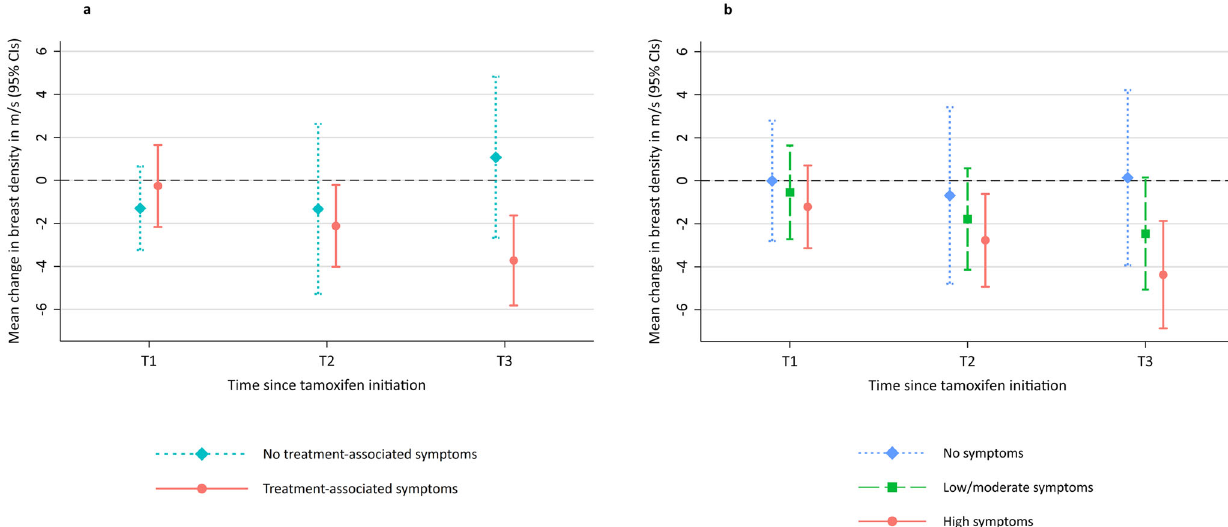
Fig. 2 Multivariable-adjusted mean change in breast sound speed (m/s) by treatment-associated endocrine symptoms and endocrine symptom frequency. a By treatment-associated endocrine symptoms. Treatment-associated endocrine symptoms were de fi ned as either emergent or worsening vasomotor symptoms and/or joint pain after tamoxifen initiation. P-trend for those with symptoms = 0.004, P-trend for those without symptoms = 0.18; P-interaction between endocrine symptom group and time = 0.02. b By endocrine symptom frequency. Endocrine symptom frequency was assessed with a Likert scale for symptom frequency per week (vasomotor and joint pain) and per day (vasomotor only). An endocrine symptom severity score was created by summing the values for each item and categorized into tertiles de fi ned as no symptoms (score = 0), low/moderate (score = 1 – 5), and high (score = 6 + ). P-trend for those with no symptoms = 0.91, low/ moderate symptoms = 0.03, high symptoms = 0.004. P-interaction between endocrine symptom frequency and time = 0.61. All models were adjusted for age, race, menopause status, body mass index, and baseline sound speed. P-trends were calculated by modeling the time interval from tamoxifen initiation (T1, T2, T3) as a continuous variable using the Wald test. P-interactions were evaluated with multiplicative interaction terms using the Wald test. Error bars represent 95% con fi dence